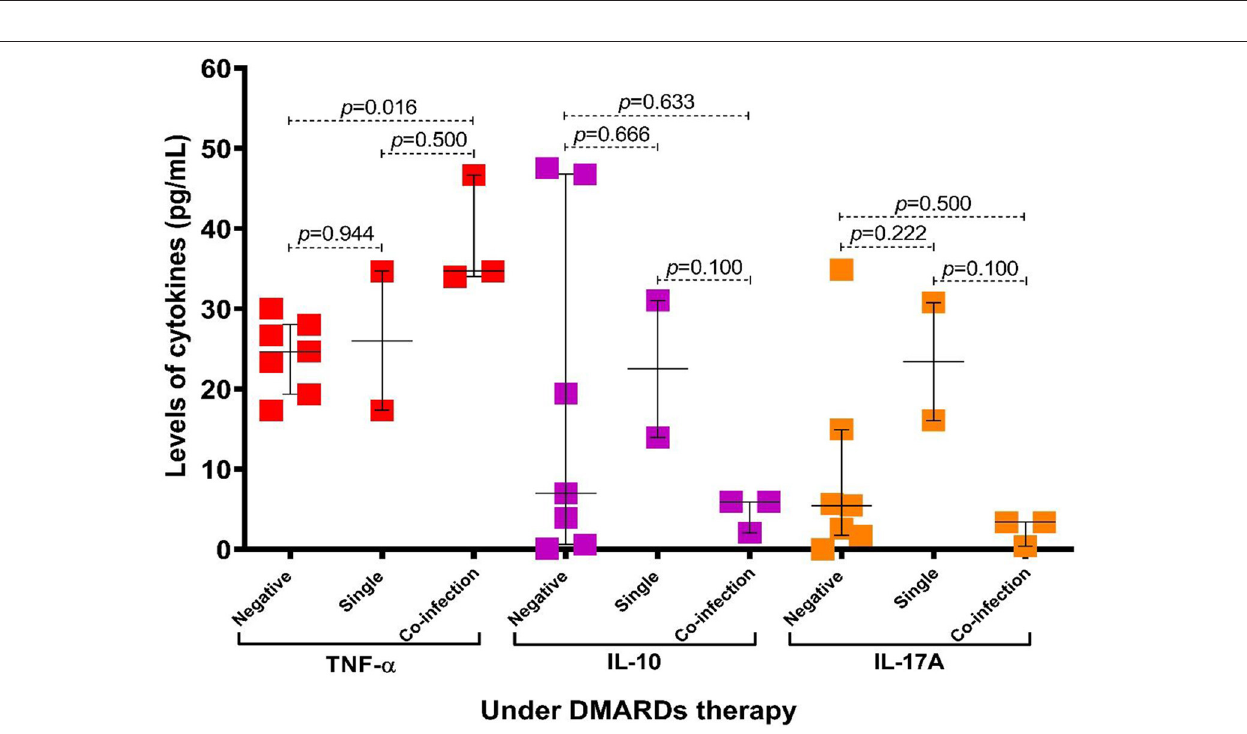
FIGURE 4 | Association of levels of cytokines according to infection status by intestinal protozoa and patients with RA under DMARDs therapy. Bars represent the median with P 5 -P 95 range. Statistical analyses were performed by Mann–Whitney U test. Significance was set at p < 0.05.